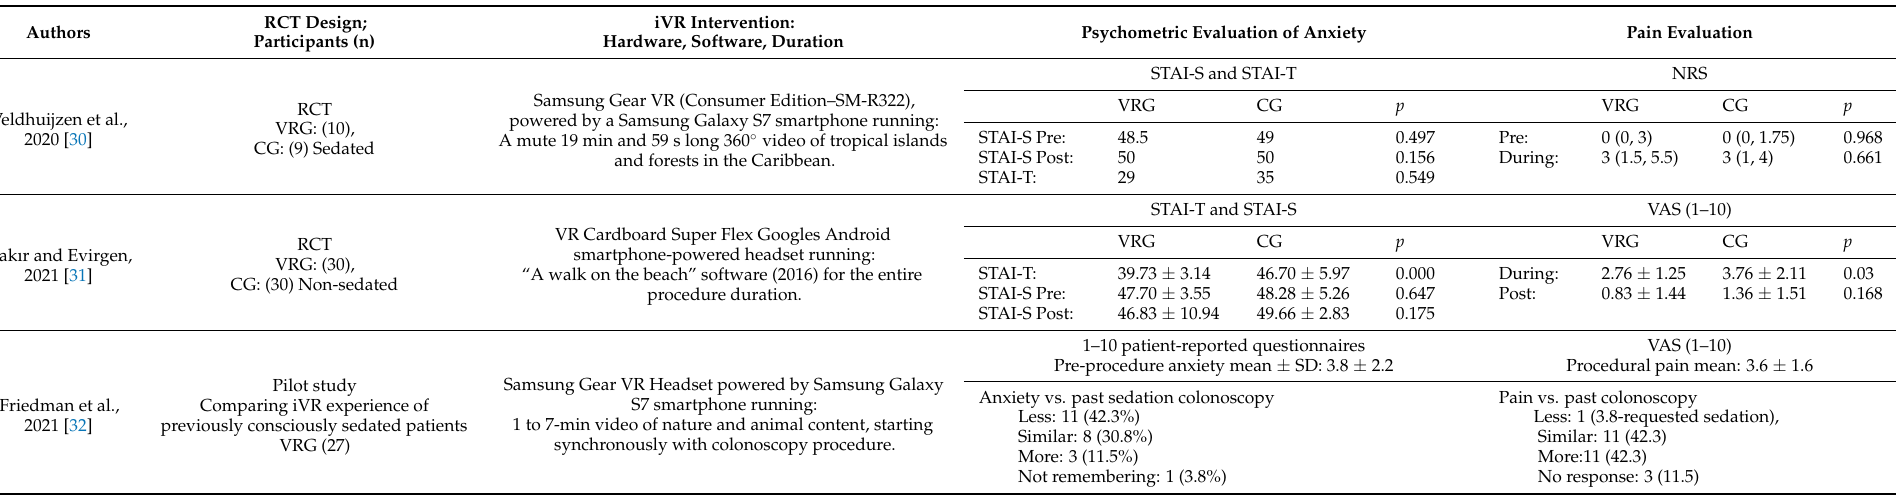
Table 2. Current interventional studies that evaluate iVR effect on colonoscopy intraprocedural induced anxiety and